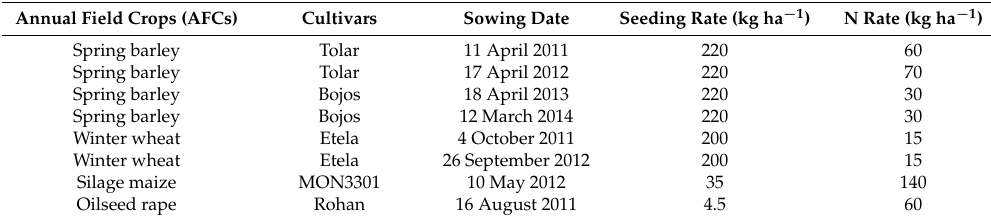
Table 2. The sowing of non-woody annual field crops (AFCs) spring barley (SB), winter wheat (WW), silage maize (SM), and oilseed rape (OR), and the fertilizer (Nitrogen—N) rate in different growing